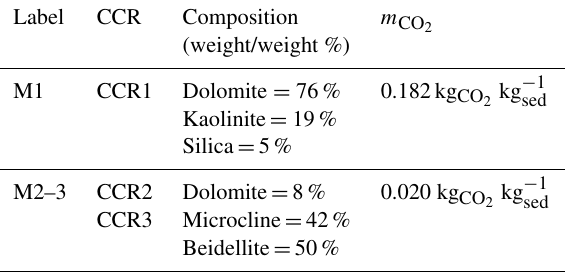
Table 2. Composition of the mineralogical scenarios used for the investigation of the three CCRs considered. The mass of CO 2 re- leased by a unit mass of sediment ( m CO gaseous CO 2 generation is activated is also listed for each